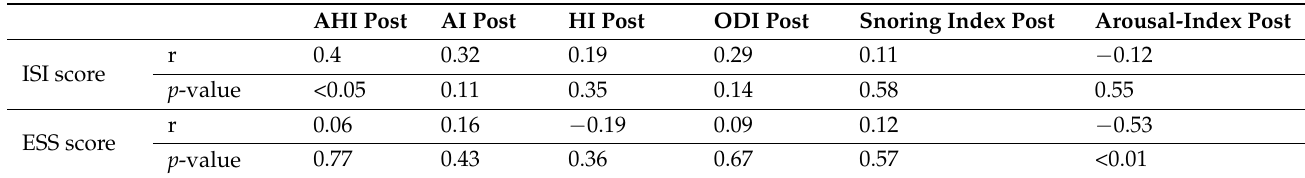
Table 2. Spearman’s rho (r) correlation coefficients between the preoperative ISI-score and ESS-score and the various postoperative PSG-metrics.